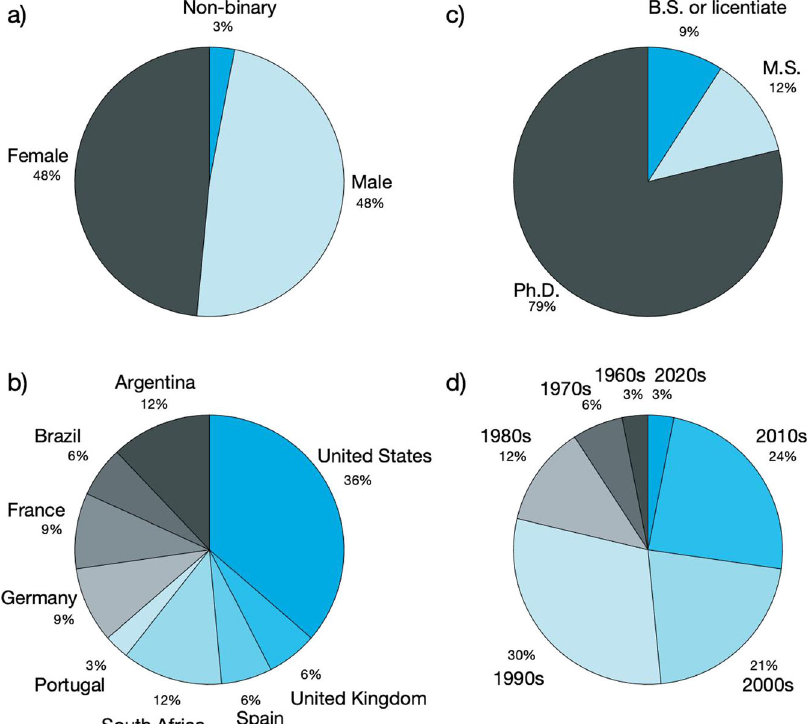
Fig. 3 SAMOC community survey. Responses from the voluntary census of the SAMOC community conducted in 2022: a ) Gender that respondents self- identi fi ed as, b ) country where they currently work, c ) terminal, fi nal, or latest degree obtained, and d ) year terminal, fi nal, or latest degree was